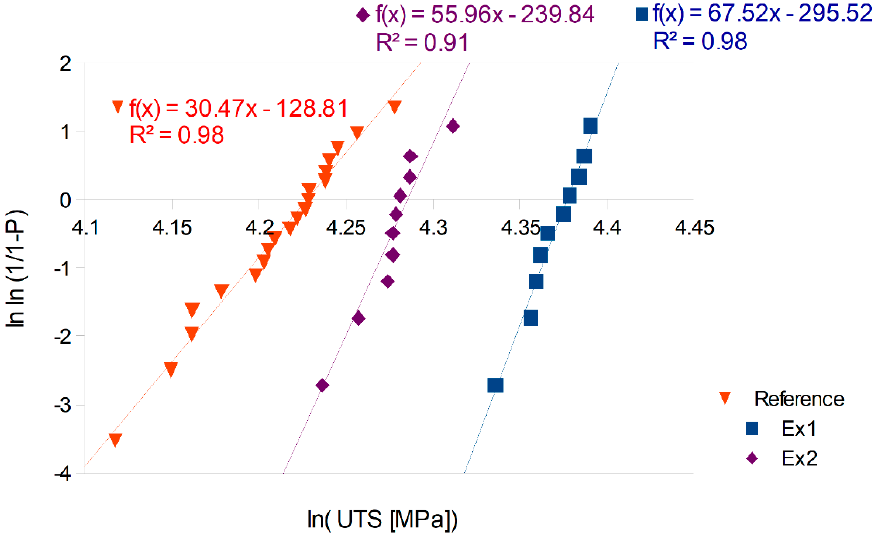
Figure 6. The Weibull modulus established by the linear